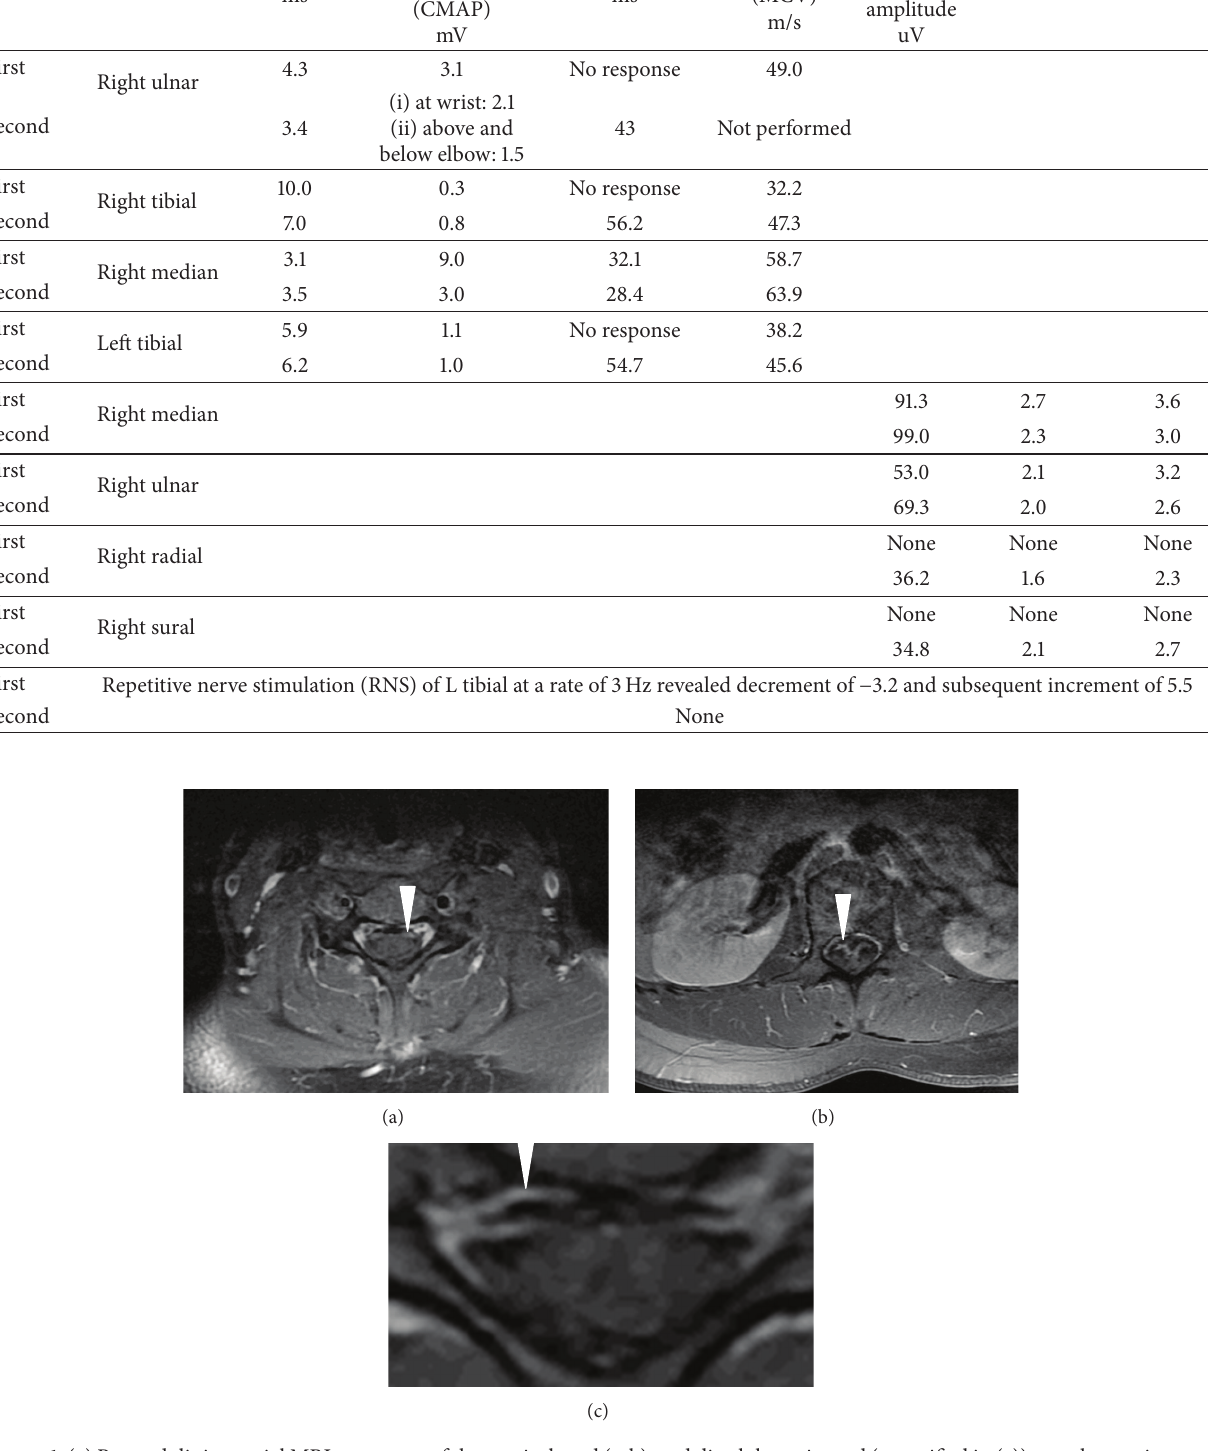
Figure 1: (a) Postgadolinium axial MRI sequences of the cervical cord (a-b), and distal thoracic cord (magnified in (c)) reveals anterior nerve root enhancement consistent with an inflammatory